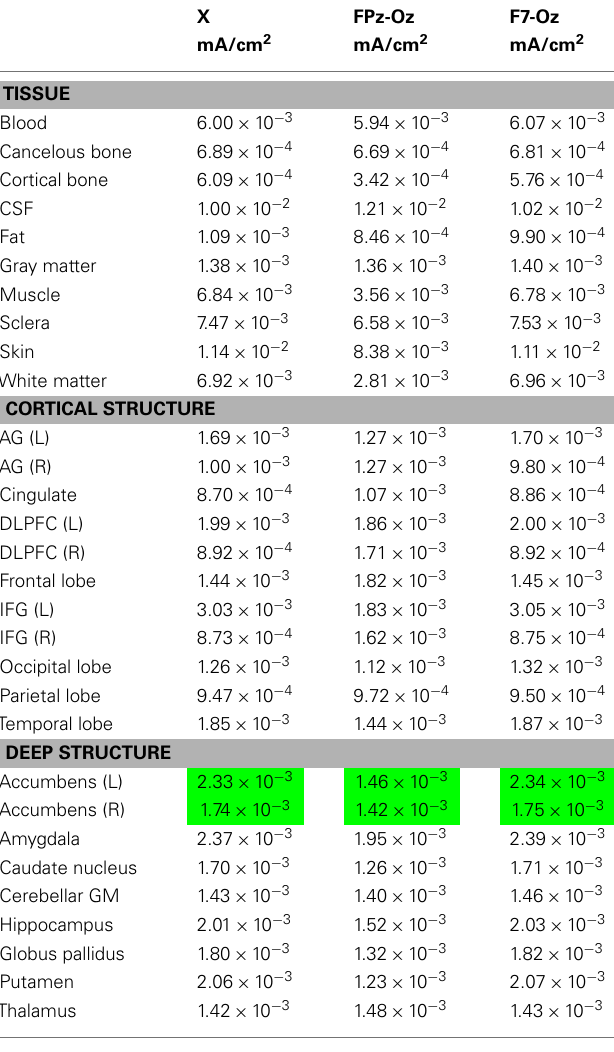
Table 3 | Median current density values found in different tissues and structures for Problem